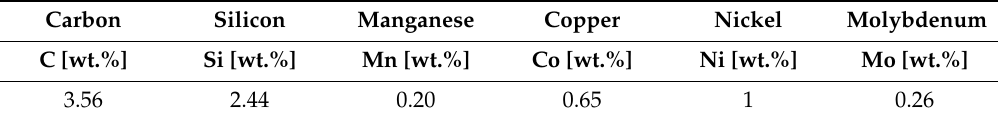
Table 1. Chemical composition of the casting batch.